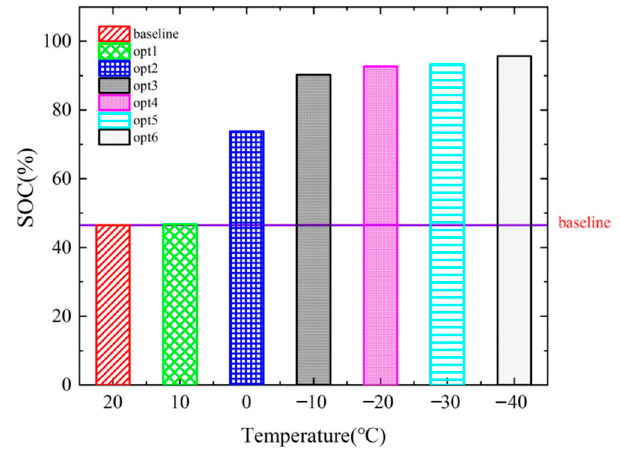
Figure 7. State of charge (SOC) in the cylinder of the benchmark and precooling scheme.